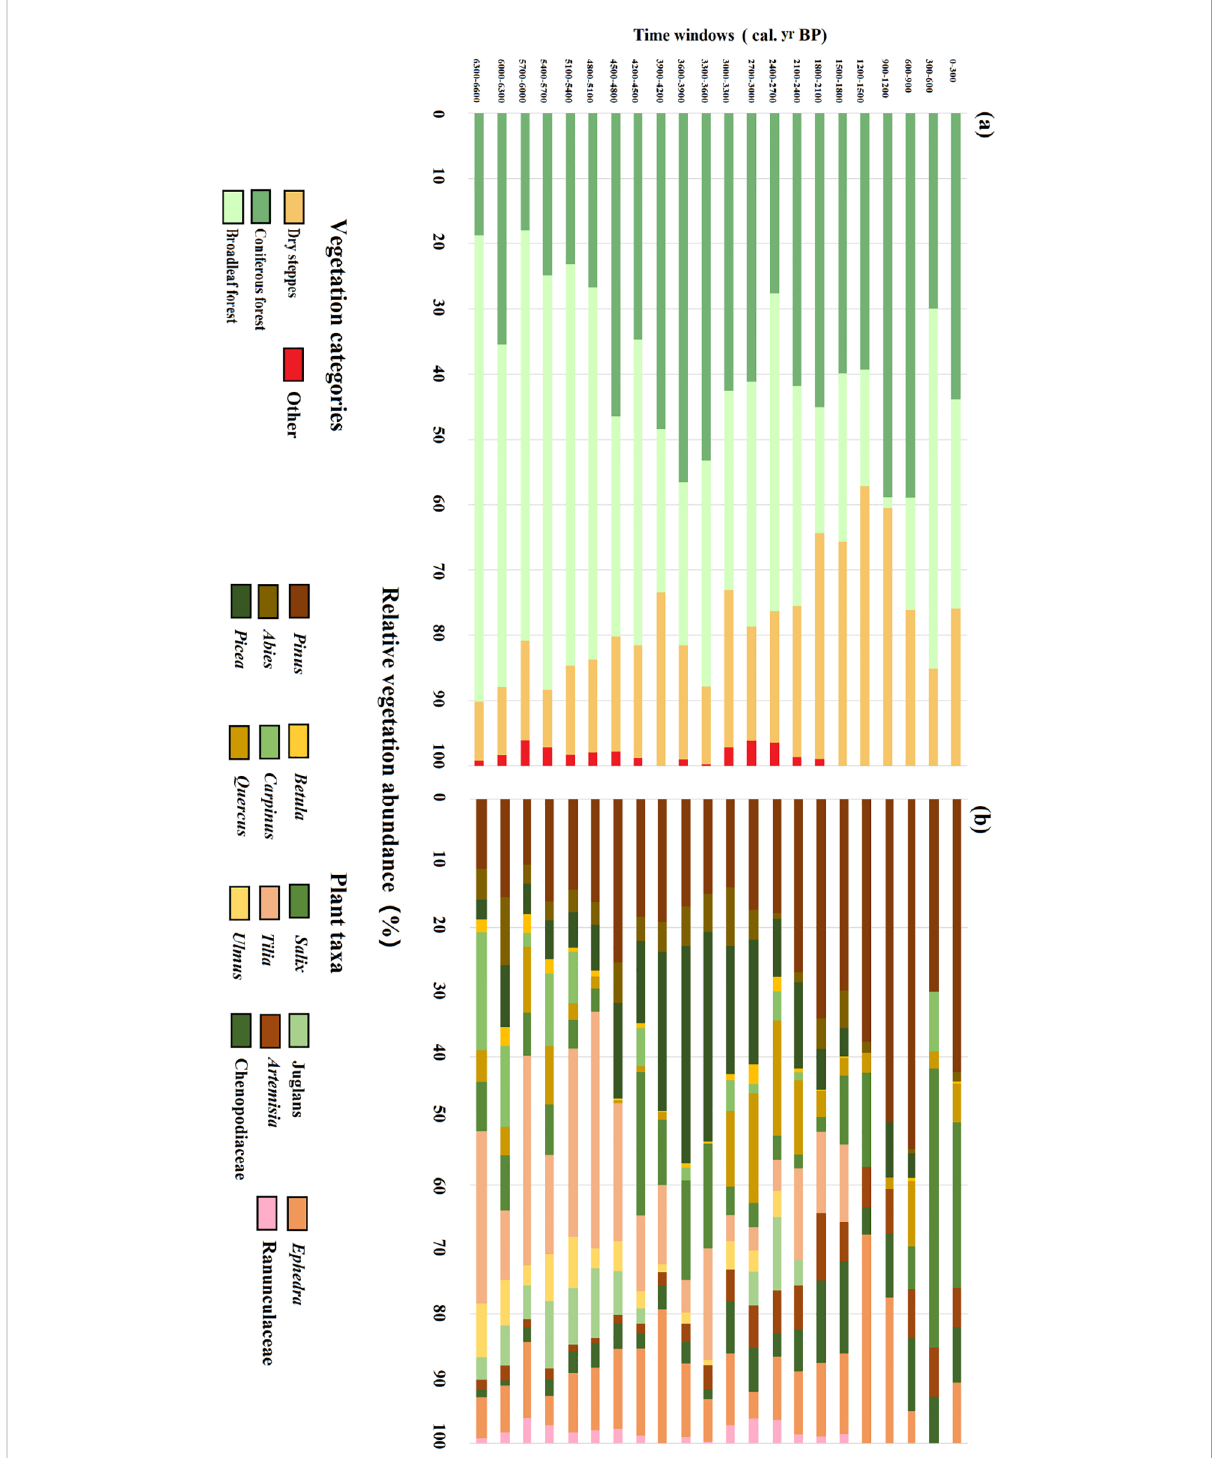
FIGURE 4 Vegetation reconstructions based on REVEALS using S4 with a wind speed of 3 m/s for marginal region. The four vegetation categories (A) and individual plant taxa (B) are